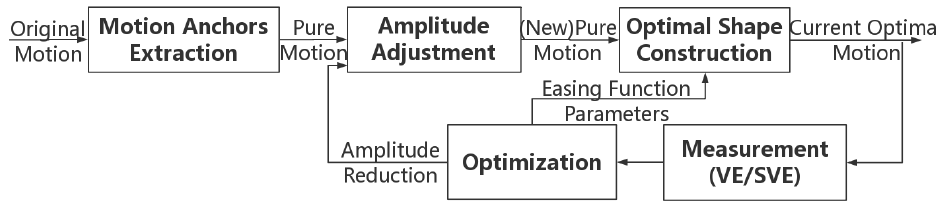
Figure 10. General procedure of motion